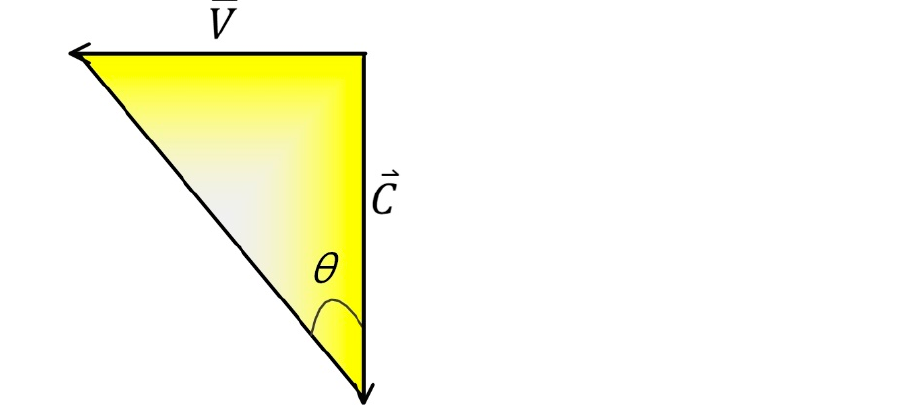
(cid:42) (cid:42) V , C , and θ . Figure 7. The schematic diagram of the relationship between 𝑉(cid:4652)⃑ , 𝐶⃑ , and θ .